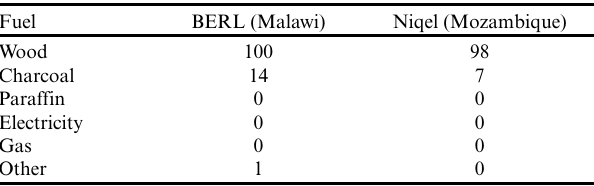
Table 9 . Fuels used for cooking (% of households) † .